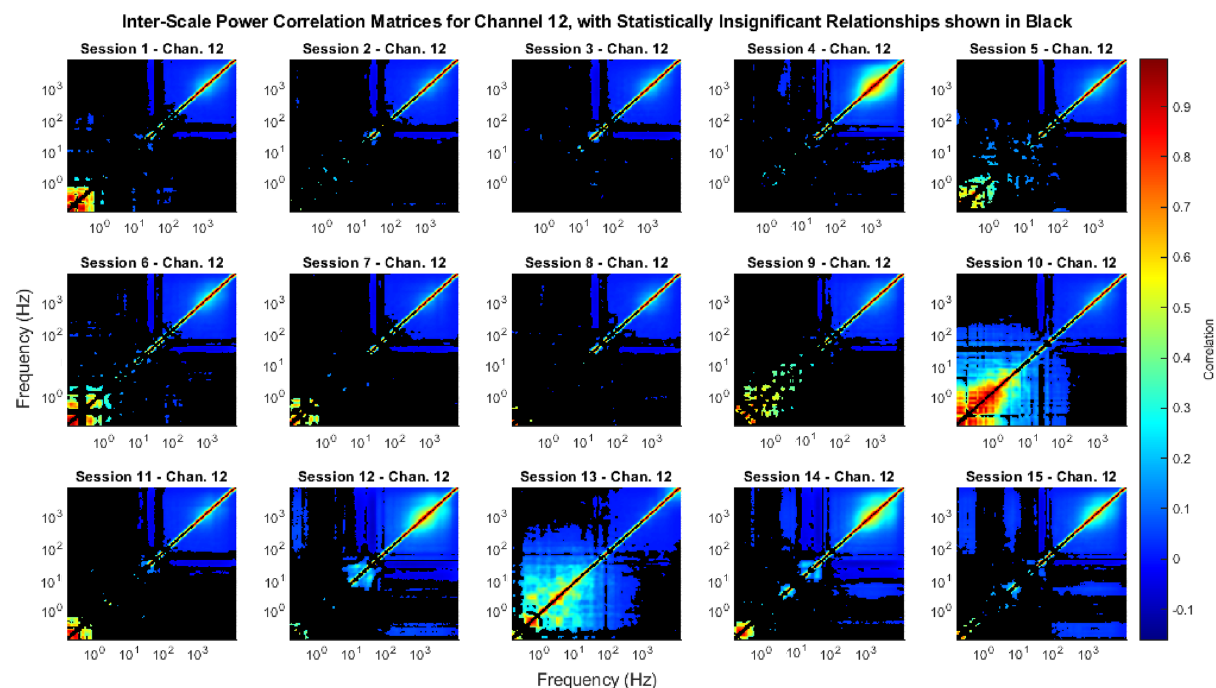
Figure 4. ISPCMs from Sessions 1–15 for Channel 12. Non-statistically significant correlations, at an FDR α of 0.01, are shown in